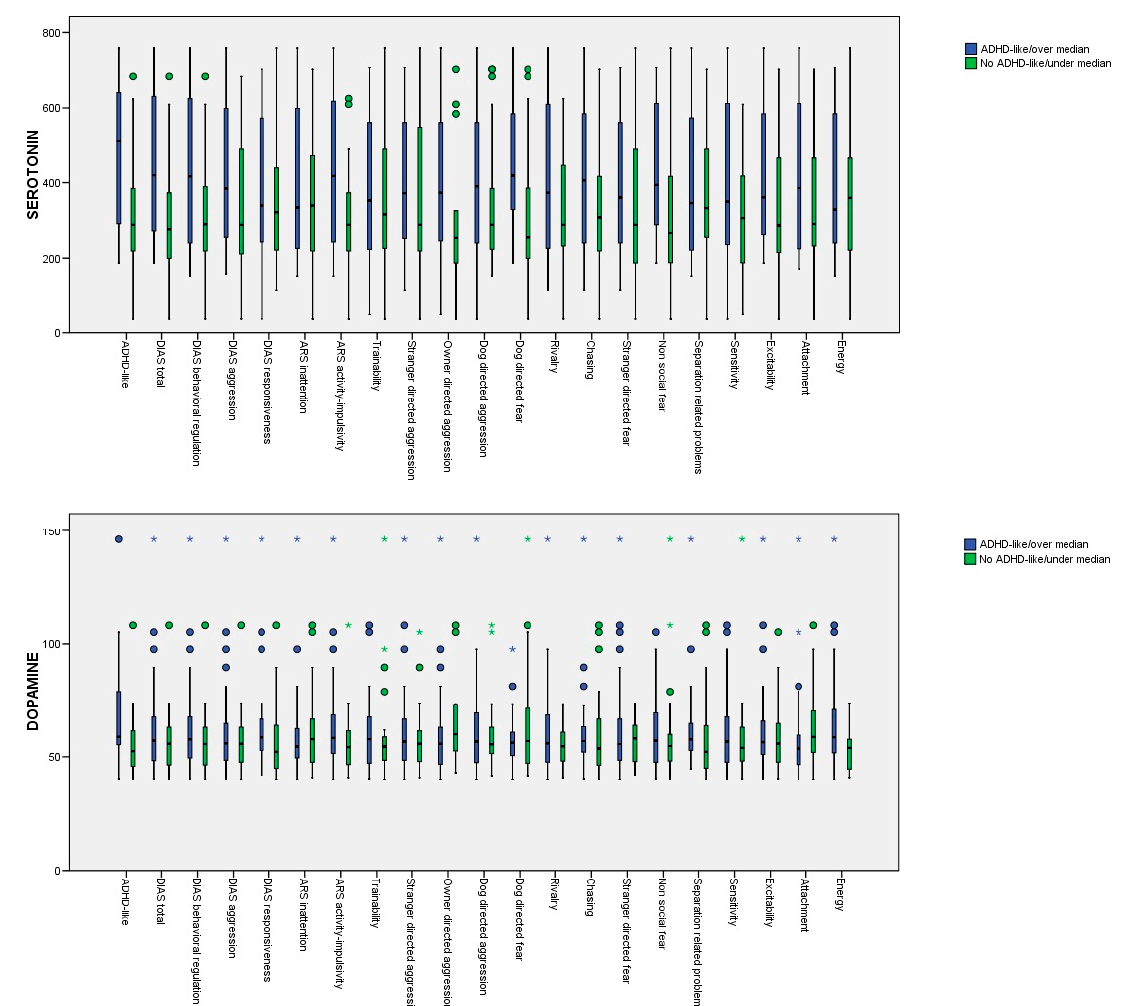
Figure 1. Box diagrams of the serotonin and dopamine levels for the dogs with suspected diagnoses of being ADHD-like (vs. the control dogs) and the dogs with scores over and under the median for the different DIAS, Dog ARS, and C-BARQ